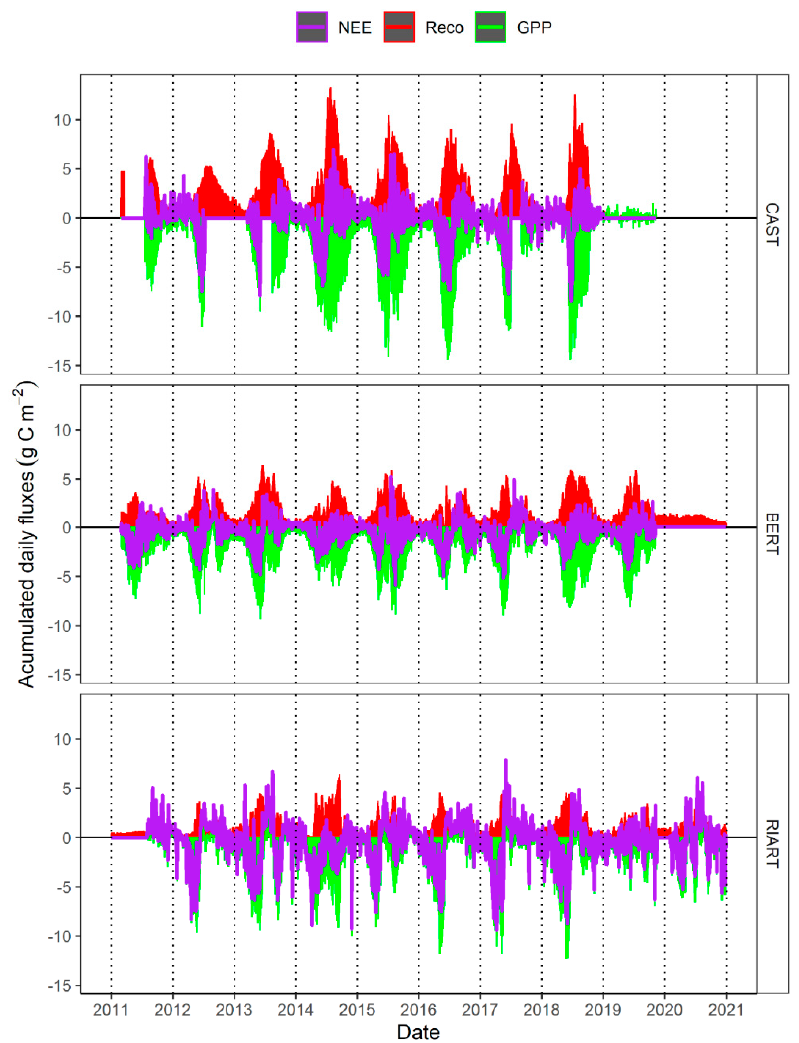
Figure 4. Interannual CO 2 flux dynamics: daily accumulated net ecosystem exchange (NEE), ecosystem respiration (R eco ), and gross primary production (GPP).